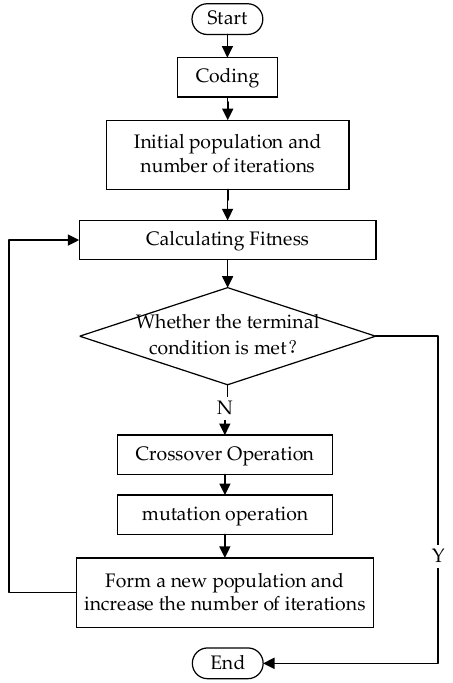
Figure 6. The steps of microservice resource scheduling based on the MFGA.